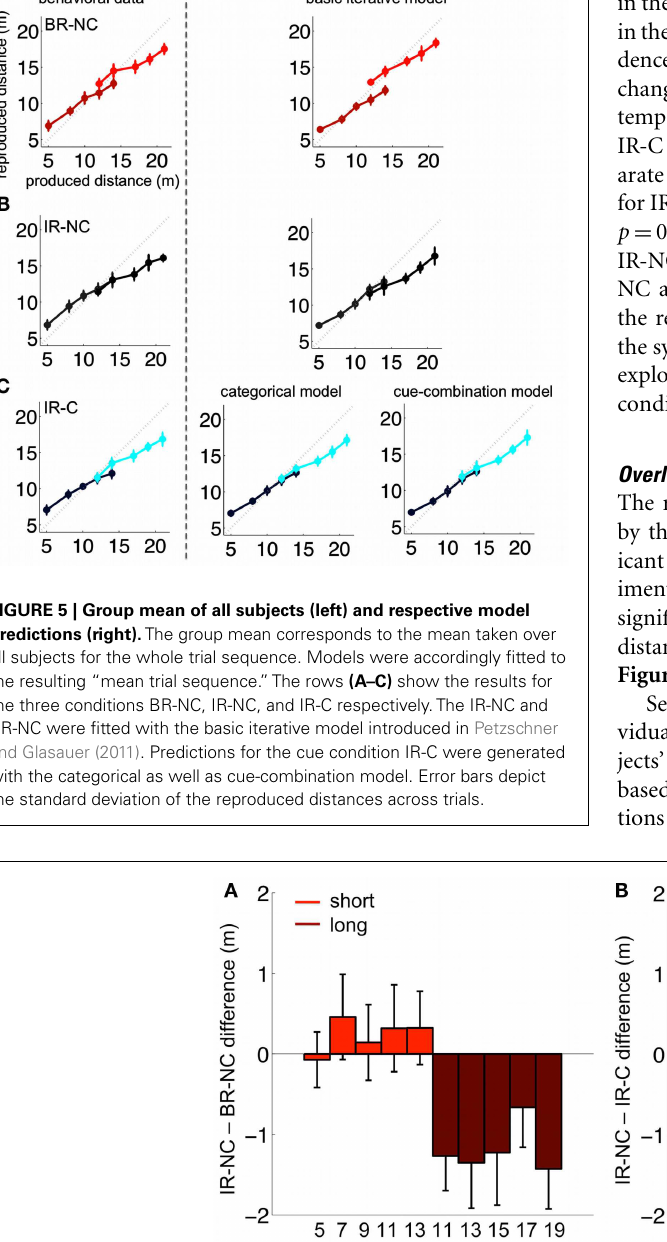
FIGURE 6 | Mean behavioral differences between conditions. (A) Difference between the IR-NC and the BR-NC conditions for the mean reproduced distances. (B) Difference between the IR-NC and the IR-C